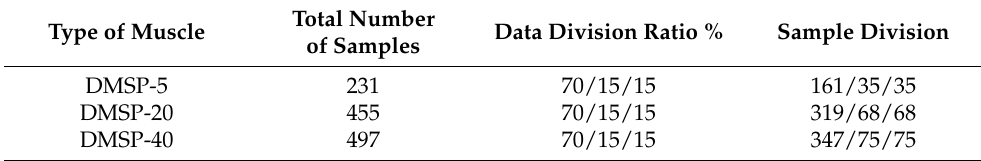
Table 4. Division ratios for training, validating, and testing the created